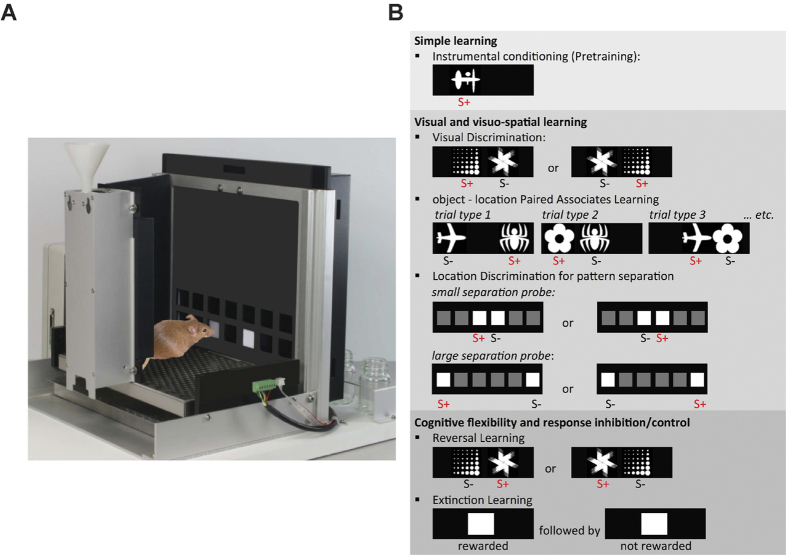
Cognitive testing in the touchscreen operant chamber.(A) Example of a Campden touchscreen operant chamber for mice. (B) Overview of the cognitive tasks: Ehmt1+/− and WT mice were tested on operant conditioning (Pretraining); Visual Discrimination; object-location Paired-Associates Learning; Reversal Learning; Extinction Learning and Location Discrimination for pattern separation. (Panel B; Adapted by permission from Macmillan Publishers Ltd: Nature Neuroscience, copyright (2013)46 and Cold Spring Harbor Laboratory Press, copyright (2013)12).